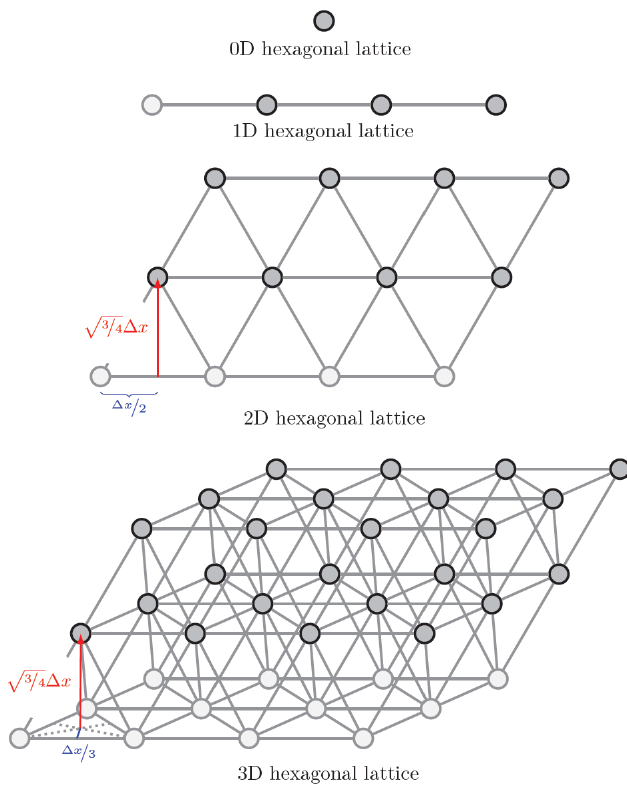
Fig. 3. Construction of a Face Centred Cubic arrangement by